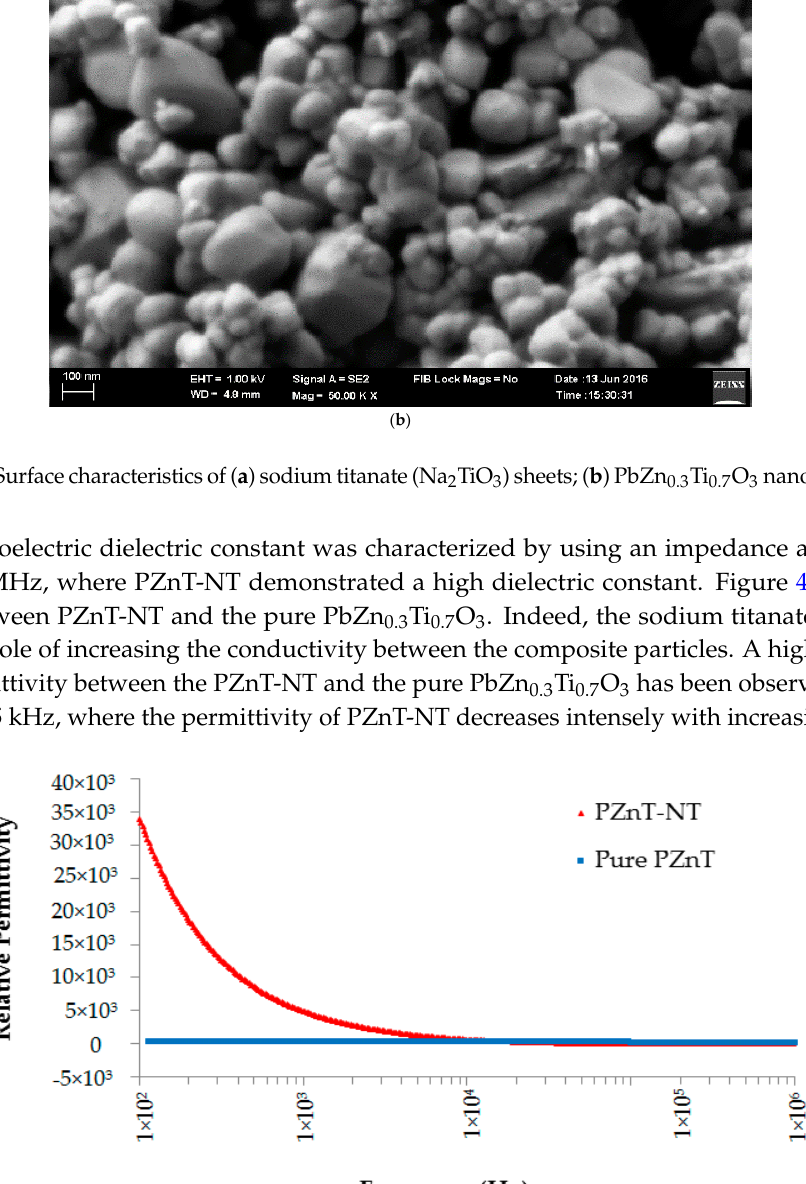
Figure 4. The dielectric properties of PZnT-NT.